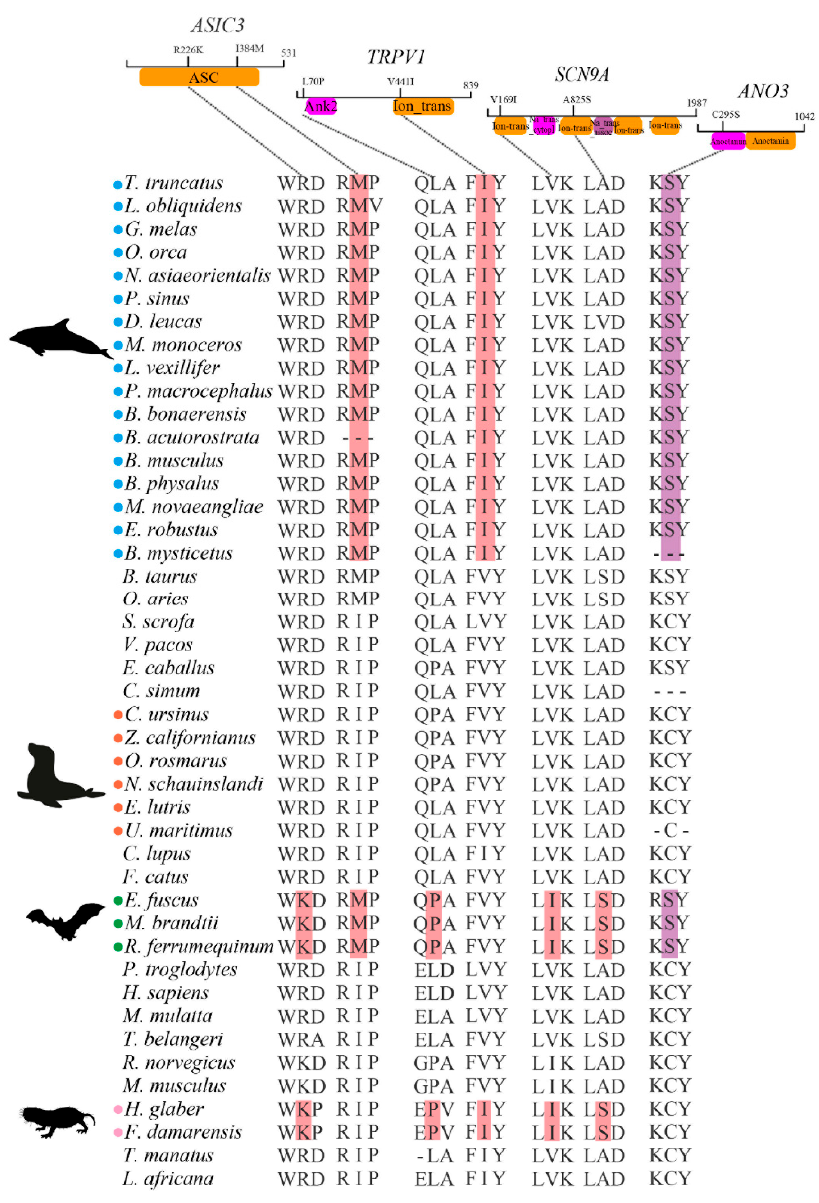
Figure 4. Potential convergent amino acids in species adapted to pain. Four groups of mammals adapted to pain are shown with circles of different colors: cetaceans (blue), other marine mammals (orange), bats (green), naked mole rats (pink). Amino acids in pink and purple are convergent amino acids associated with pain sensation and analgesia genes, respectively. These convergent amino acids are annotated on the protein domains ( on the top ). Amino acid positions are at the human